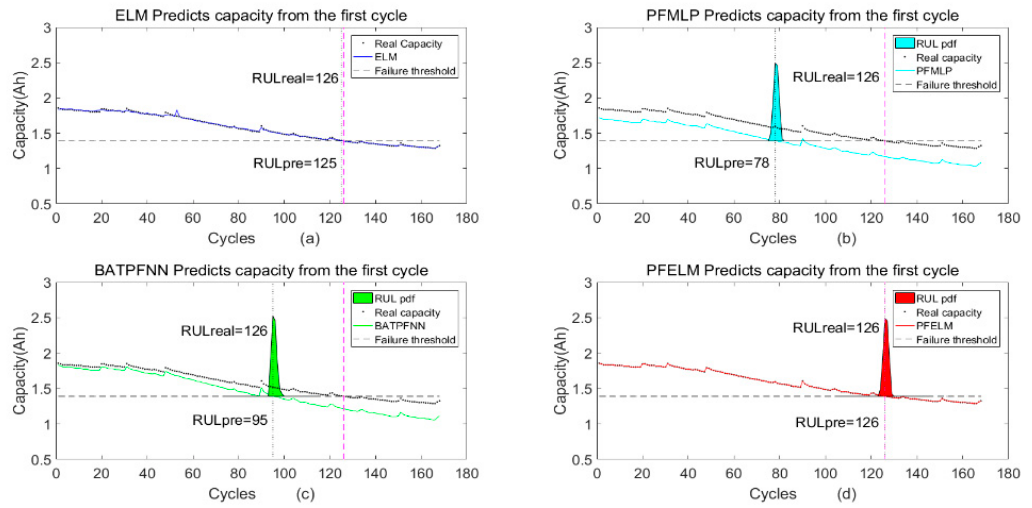
each cycle, and the black dotted line parallel to the horizontal axis is the battery failure threshold line. The blue curve, cyan-blue curve, green curve and red curve are the capacity decline curves obtained by